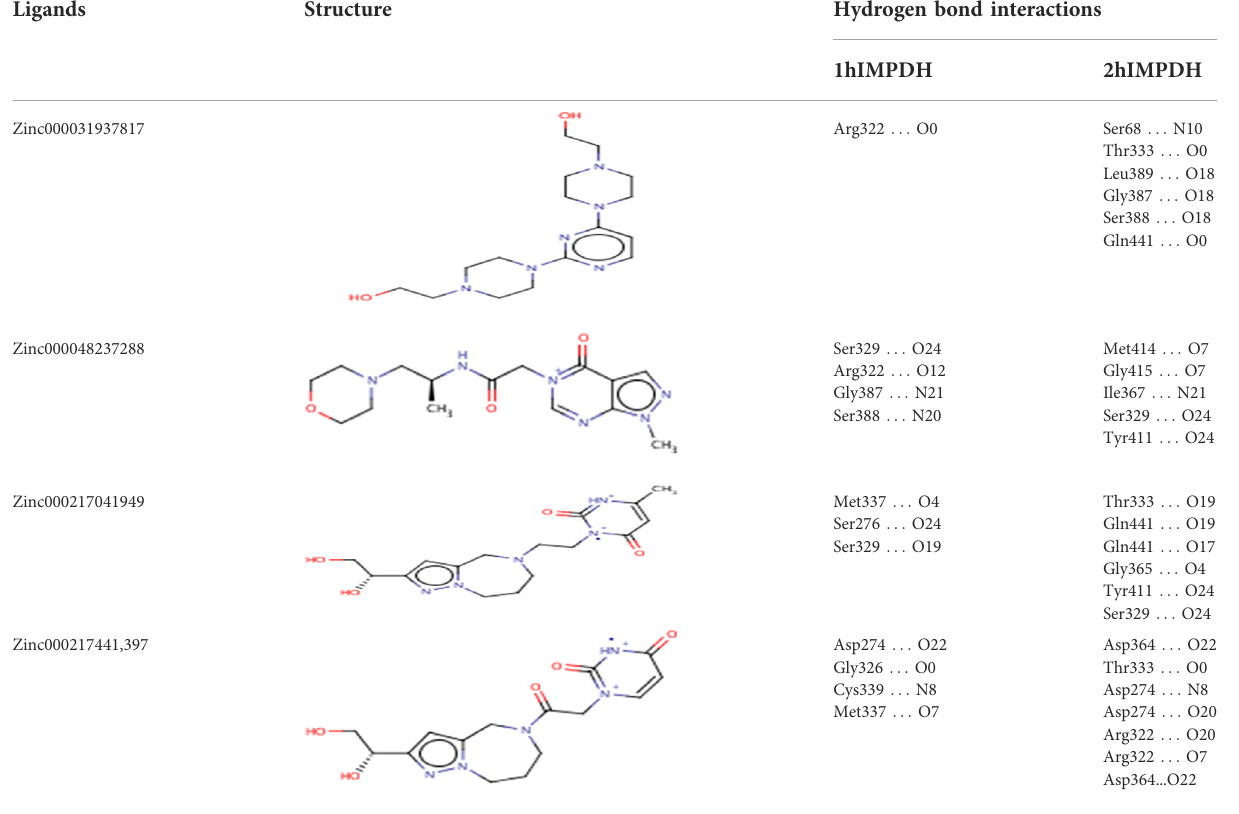
TABLE 3 ( Continued ) Structures and hydrogen bonds of topmost ligands in complex with IMPDH isoforms over double-step